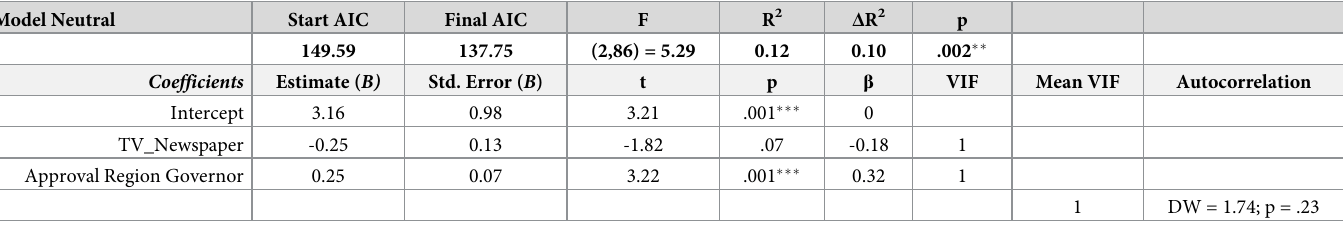
Table 4. Multiple regression statistics of the neutral model.